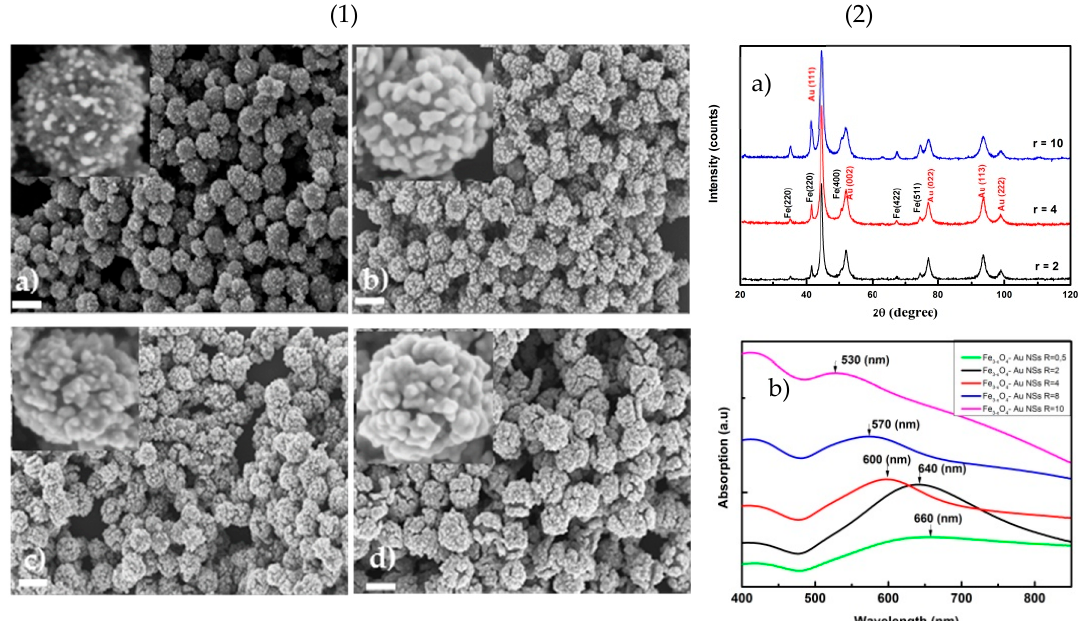
Figure 6. ( 1 ) SEM images of γ -Fe 2 O 3 ‒ Au NSs with different seed/HAuCl 4 ratios of ( a ) r = 10, ( b ) r = 4, ( c ) r = 2, ( d ) r = 0.5. The scale bars are 200 nm in both figures; ( 2 ) XRD patterns ( a ) and UV-Vis spectra of Fe 3-x O 4 ‒ Au NSs with different r values ( b ).